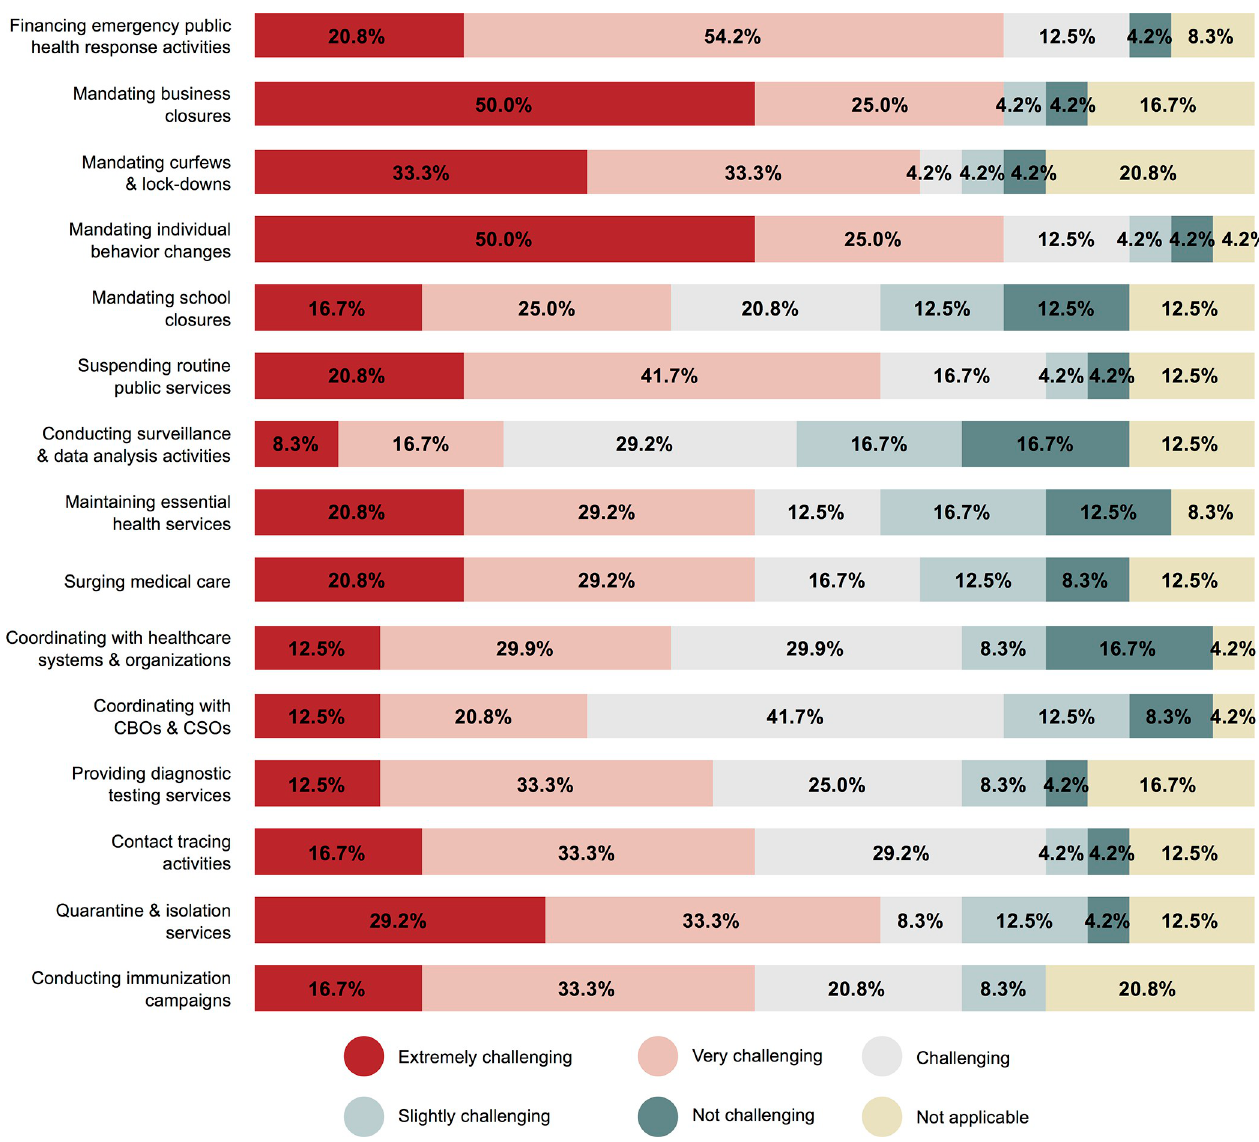
Fig 3. Likert-scale results regarding how challenging pandemic response activities were perceived to be in cities (n = 24); Community-based organizations (CBOs), Civil society organizations (CSOs).